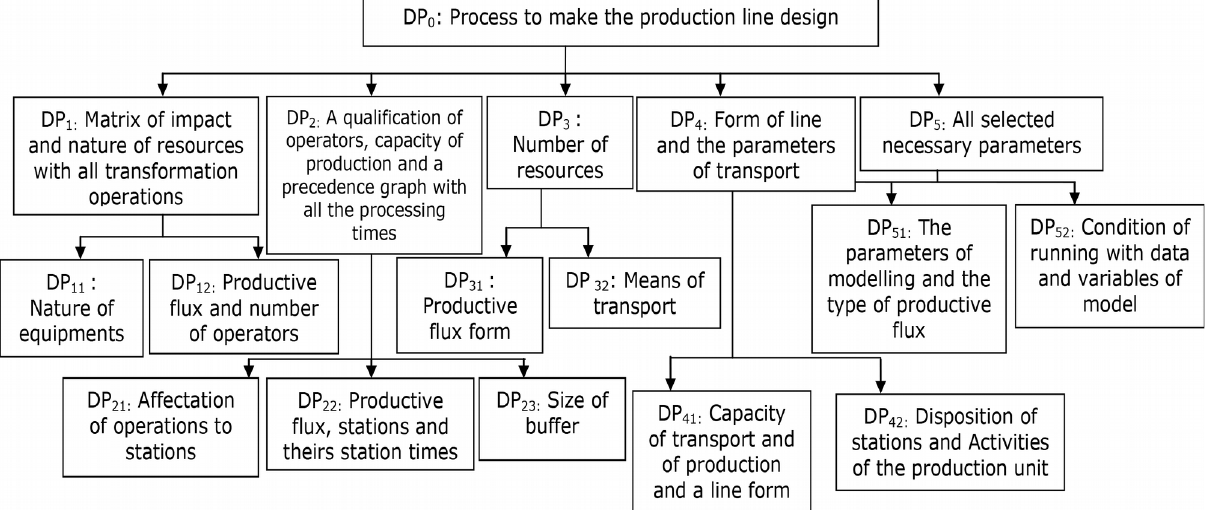
Figure 12. The hierarchical decomposition of